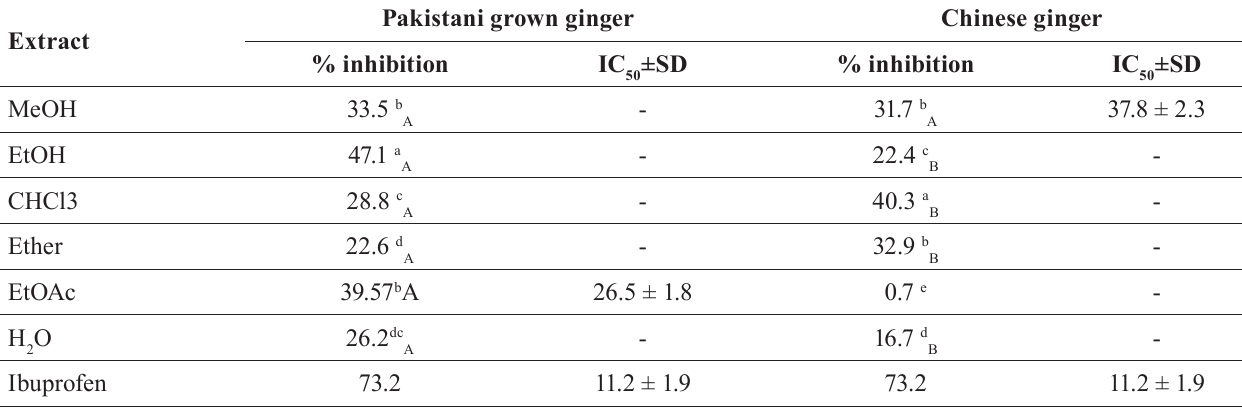
TABLE II - Anti-inflammatory activity of extracts from Pakistani grown and Chinese ginger